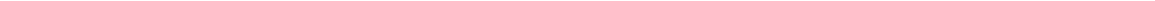
Fig. 5 Overexpression of NbBeclin1 promotes autophagy-dependent degradation of NIb and inhibits TuMV replication. a , b Immunoblotting of total protein extracts from the N . benthamiana leaves agroin fi ltrated with buffer ( − ) or the plasmids indicated. The membrane was probed with GFP (@GFP), or Myc antibodies (@Myc). c Immunoblotting analysis of total protein extracts from leaves in fi ltrated with buffer ( − ) or TuMV-CFP-NIb together with an empty vector (Vec) or Myc-NbBeclin1 with antibodies against GFP or Myc. d Quanti fi cation of TuMV RNA levels by qRT-PCR. RNA was extracted from leaves agroin fi ltrated with TuMV-CFP-NIb together with Vec or Myc-NbBeclin1 at 60 hpi. Values represent means ± SD relative to plants in fi ltrated with TuMV- CFP-NIb and Vec ( n = 3 biological replicates). The data were analyzed using Student ’ s t -test and asterisks denote signi fi cant differences between the two treatments (two-sided, ** P < 0.01). e Immunoblotting analysis of total protein extracts from leaves co-in fi ltrated with 6K2-GFP and buffer ( − ), empty vector (Vec), or Myc-NbBeclin1. Antibodies against GFP or Myc were used as a primary antibody. f , g The effect of the autophagy inhibitor 3-MA on the NbBeclin1-mediated degradation of NIb-YFP or TuMV-CFP-NIb. Total proteins were isolated from plant leaves agroin fi ltrated with NIb-YFP alone or with Myc-NbBeclin1 ( f ) or TuMV-CFP-NIb alone or with Myc-NbBeclin1 ( g ) followed by DMSO or 3-MA treatment. h , i The effect of silencing of NbATG8a